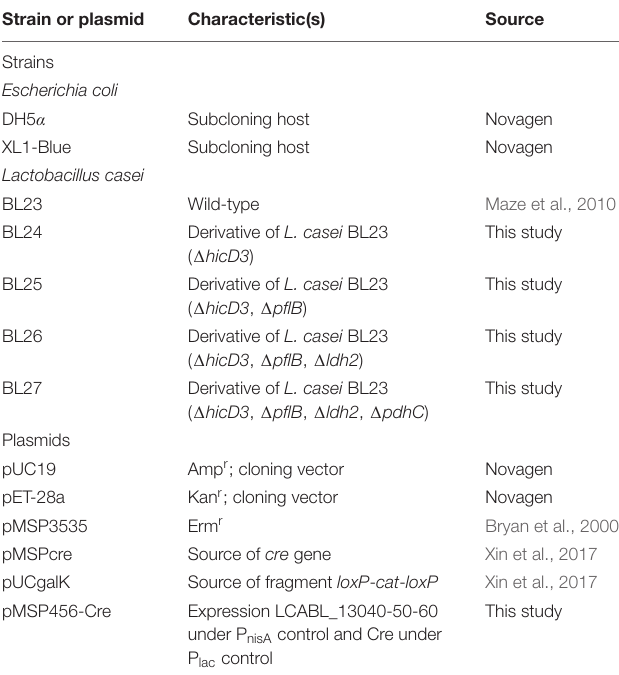
TABLE 1 | Plasmids and bacterial strains used in this